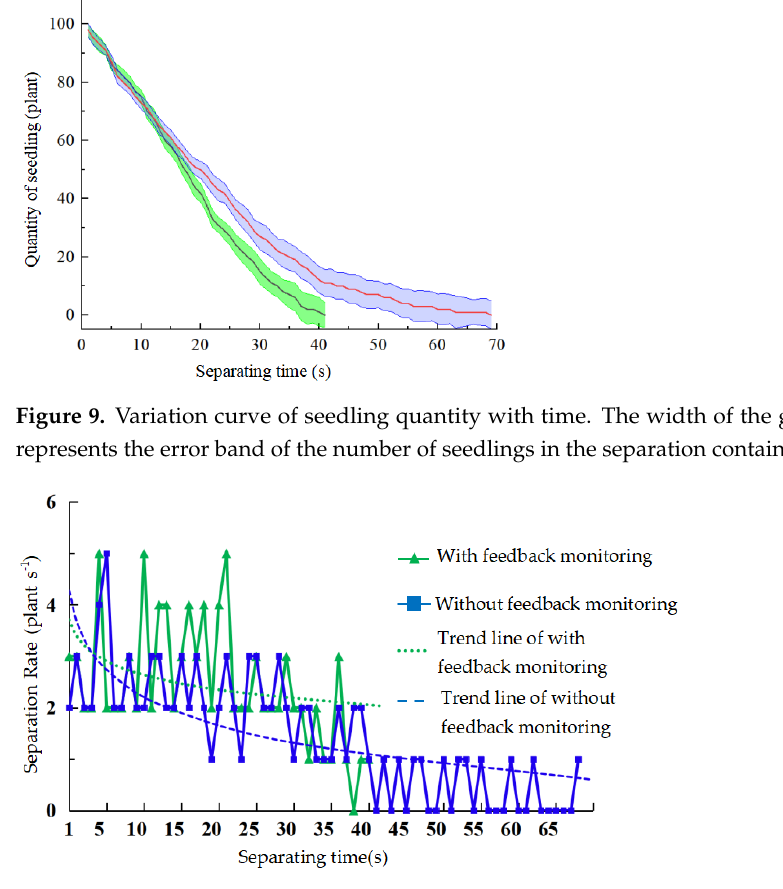
Figure 11. Response surfaces of two factors for the effective blowing rate: ( a ) Number of subdivided air stream operations. ( b ) Damage rate.